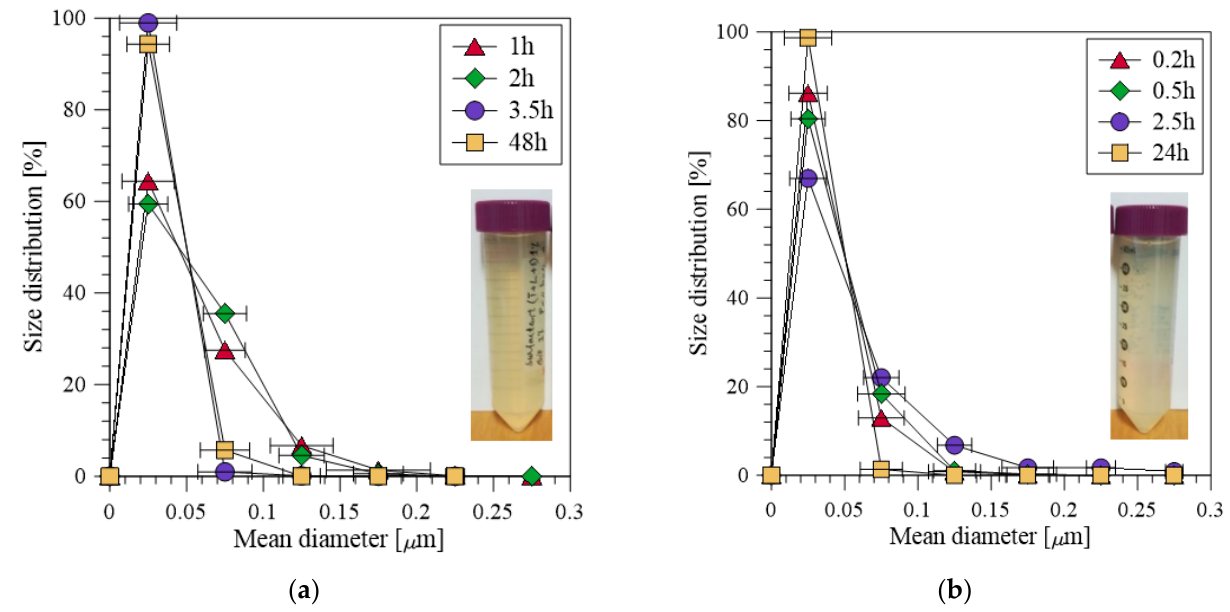
Figure 5. Droplet size distribution of emulsions ( a ) in distillate water and ( b ) in 3.5% NaCl solution at applied pressure of 0.25 bar.